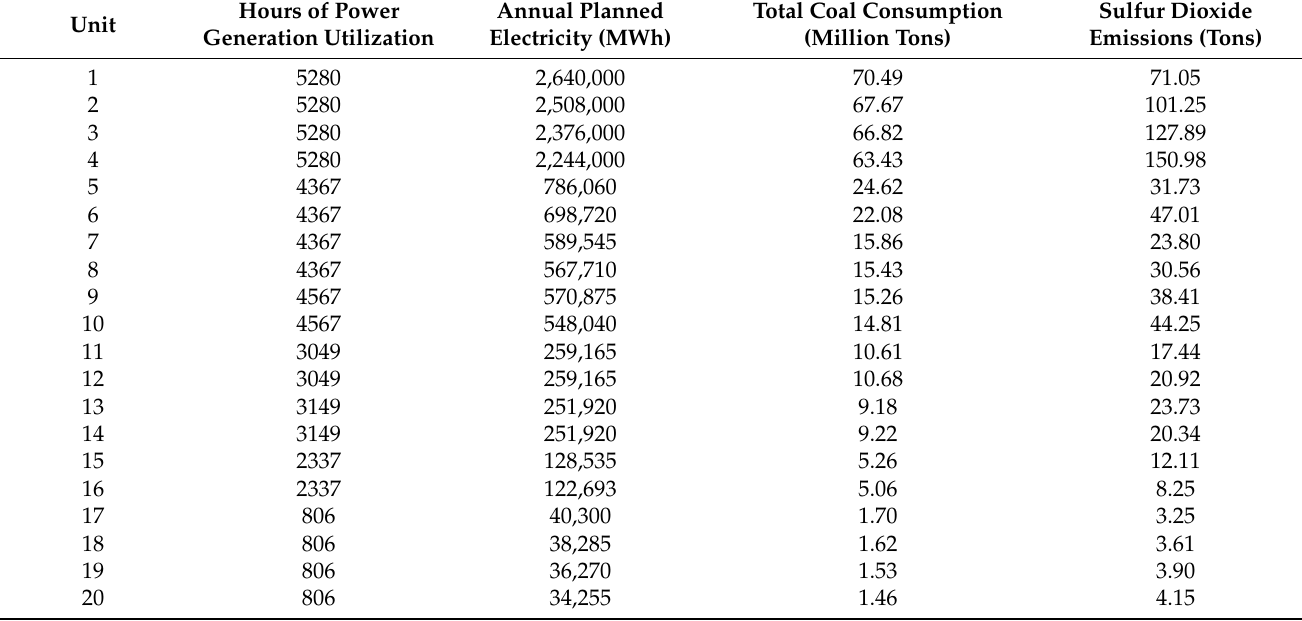
Table A3. Annual energy scheduling results of each unit according to the dynamic difference